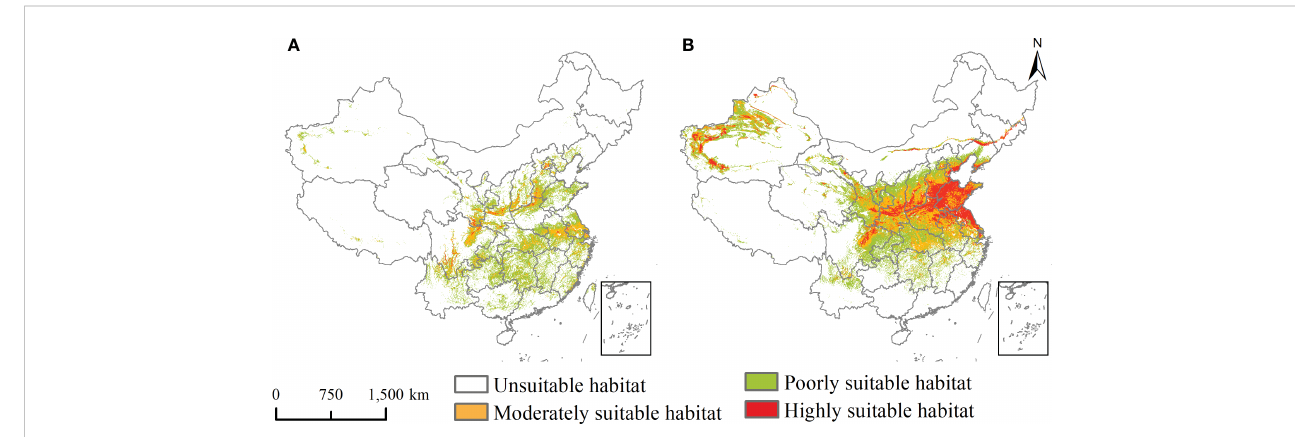
FIGURE 3 Potential geographical distribution of (A) Lolium temulentum and (B) Aegilops tauschii under the current